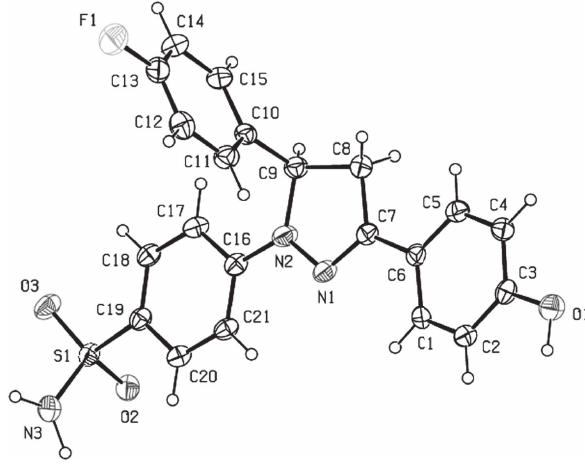
Table 1: Data collection and handling.